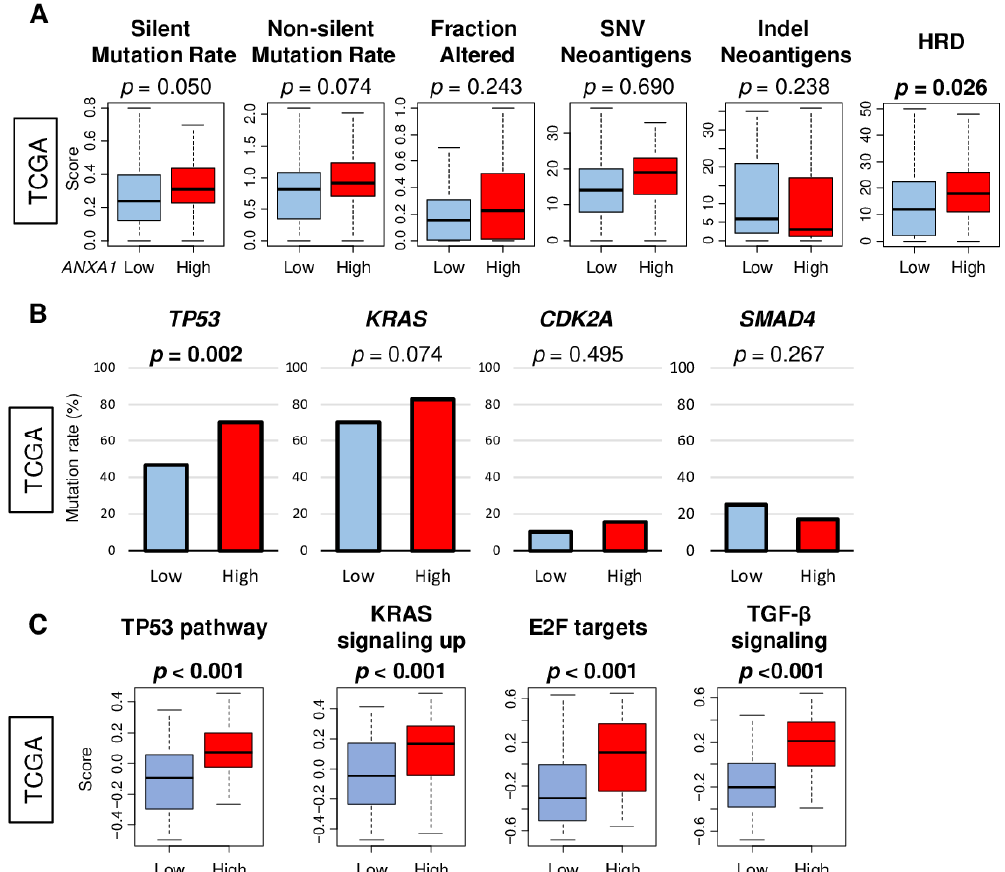
Figure 3. The association of ANXA1 with gene mutation and homologous recombination deficiency (HRD) in the TCGA pancreatic cancer cohort. ( A ) Bar plots of the mutation rate of KRAS , TP53 , CDK2A , and SMAD4 by ANXA1 low and ANXA1 high groups. p -values were calculated with Fisher’s exact test. ( B ) Boxplots of the mutation-related scores, including altered fraction, single nucleotide variant (SNV) and indel neoantigens, and silent and non-silent mutations, and ( C ) HRD scores by ANXA1 low (blue) and ANXA1 high (red) groups. Median cut-off was used to divide into ANXA1 low and ANXA1 high groups ( n = 88, respectively). p -values were calculated by the Mann–Whitney U test.